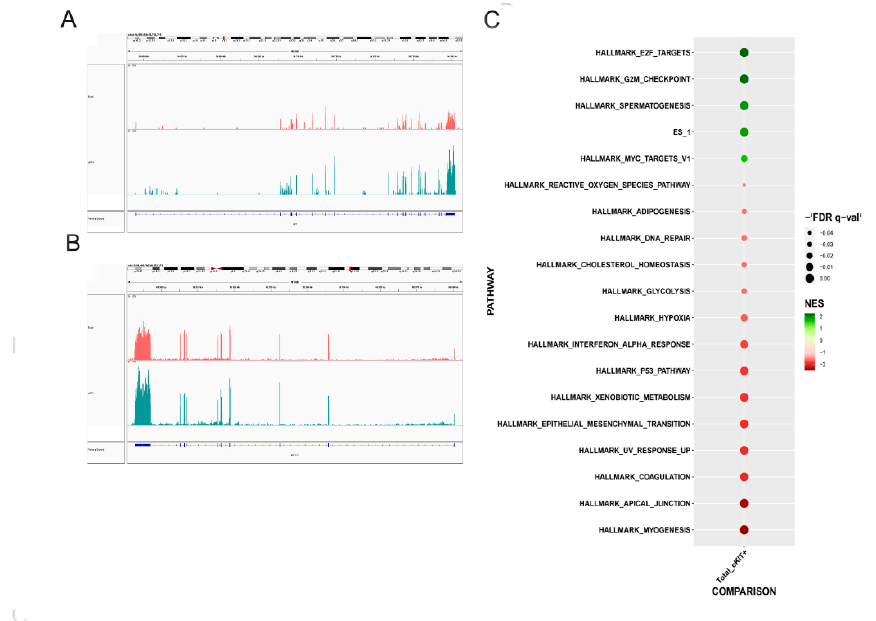
Figure 1. Total amniotic fluid cells and selected for c-Kit: analysis with bulk-RNAseq. ( A ) Gene expression level of KIT gene in the total (purple) and the selected sample (blue). ( B ) Gene expression level of KIT ligand gene in the total (purple) and the selected sample. ( C ) Gene set enrichment analysis using HALLMARK collection. Upregulated pathways in selected cells are in green, while downregulated pathways are in red.